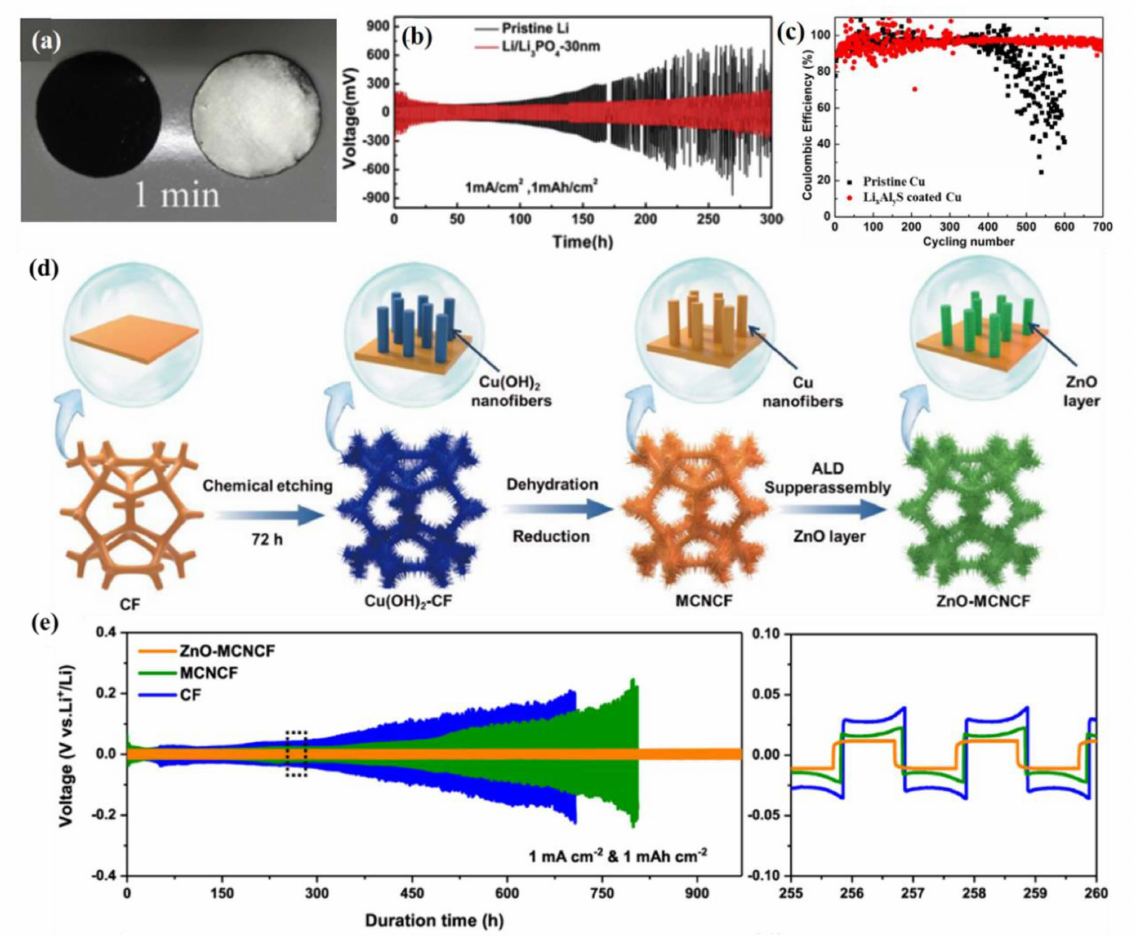
Figure 7. ( a ) Photographic images showing the corrosion of Li metal electrodes exposed to the air after 1 min (the left disc of the image is pristine Li and the right disc is Li/Li 3 PO 4 − 30 nm), ( b ) Comparison of voltage profiles of the symmetric Li − Li cells with pristine Li electrode and Li/Li 3 PO 4 − 30 nm electrode in 1 mA cm − 2 with a discharge/charge capacity of 1 mAh cm − 2 . Reprinted with permission from Ref. [126]. Copyright 2017, Elsevier. ( c ) Columbic efficiency of Li deposition/stripping with pristine Cu or 25 nm LixAlyS − coated Cu. Reprinted with permission from Ref. [130]. Copyright